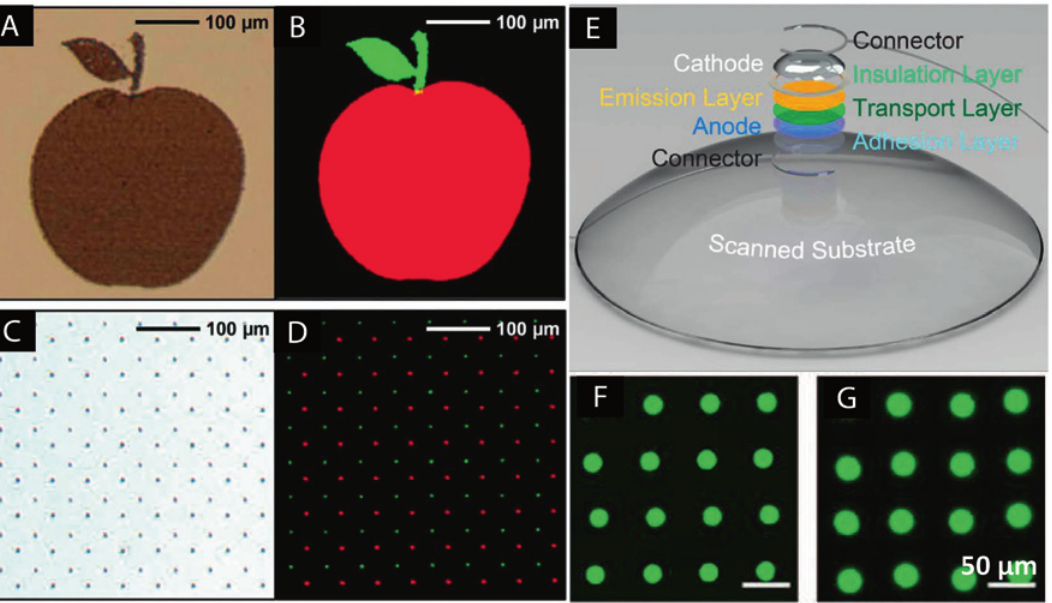
Figure 14: QD LEDs written using inkjet printing. (A – D) Varying patterns of QDs written on a substrate, demonstrating the high resolution and multi-material capability of the EHDP process. Optical image (A) and composite fluorescent image (B) of an apple printed using red and green QDs.Opticalimage(C)andcompositefluorescentimage(D)ofarraysofredandgreenQDsprintedusingthedropondemandmode.Reprinted with permission from Ref. [182]. (E) Schematic of the 5-layer QD LED written using fi ve distinct inks. The structure was printed on a curvilinear substrate, speci fi cally a contact lens, in order to demonstrate conformal printing on non fl at substrates. Reprinted with permission from Ref. [183]. (F – G) Arrays of QDs with varying droplet size. Reprinted with permission from Ref.